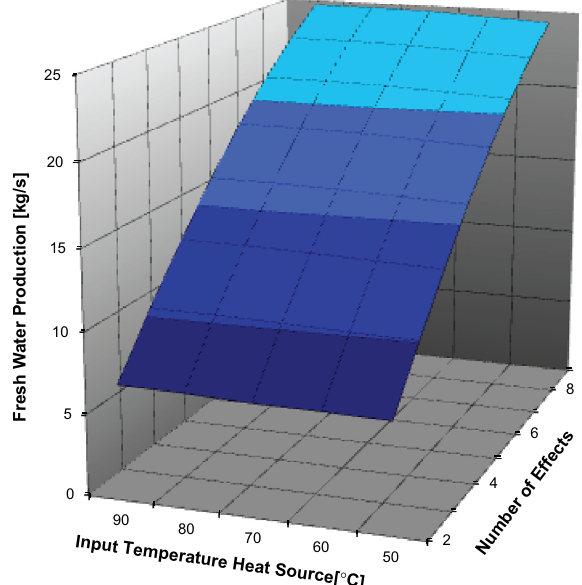
Figure 2. Dependency of the freshwater production on the heat source input temperature and the number of effects, shown for an example standard